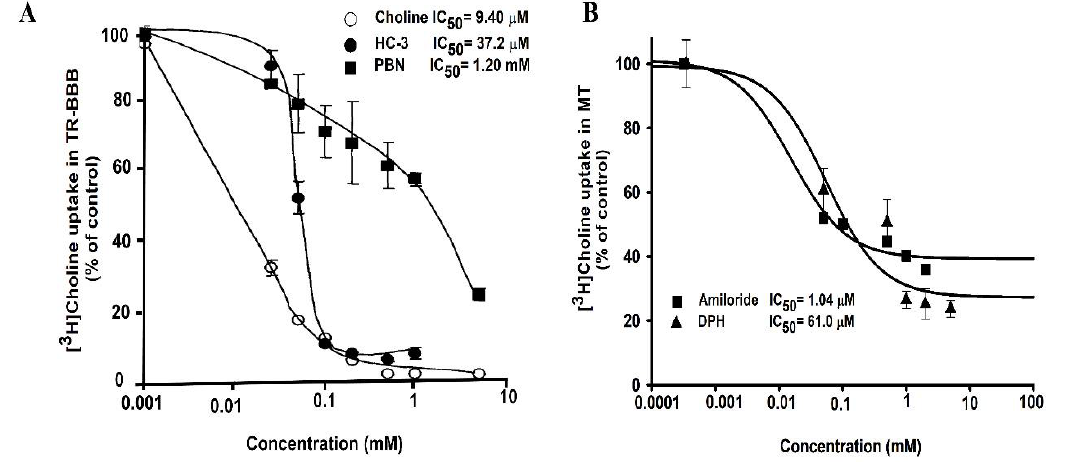
Figure 3. Inhibitory effect of drugs in a dose–response manner. ( A ) Inhibition of choline uptake inhibition by choline, hemicholinium-3, and α-phenyl- n -butyl nitrone (PBN) in TR-BBB cells. These data were retrieved and analyzed from the earlier published study by Kang et al., 2005, in rat brain capillary endothelial cell lines (TR-BBB). ( B ) Half inhibitory con- centrations (IC 50 ) were analyzed either in the presence or absence of diphenhydramine (DPH), and amiloride at concen- trations of 0–2 mM at pH 7.4 and 37°C on [ 3 H]choline uptake in the ALS disease model cell line (MT). Data are represented as the mean ± S.E.M ( n =